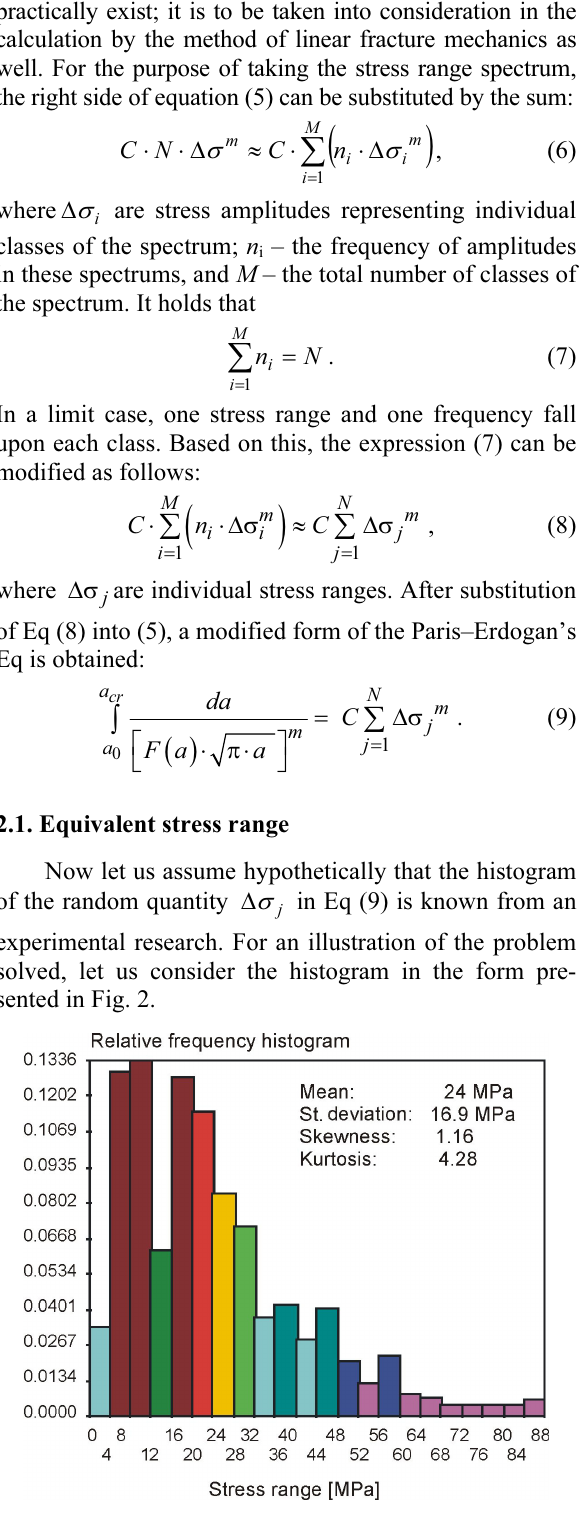
Fig. 2. Histogram of stress